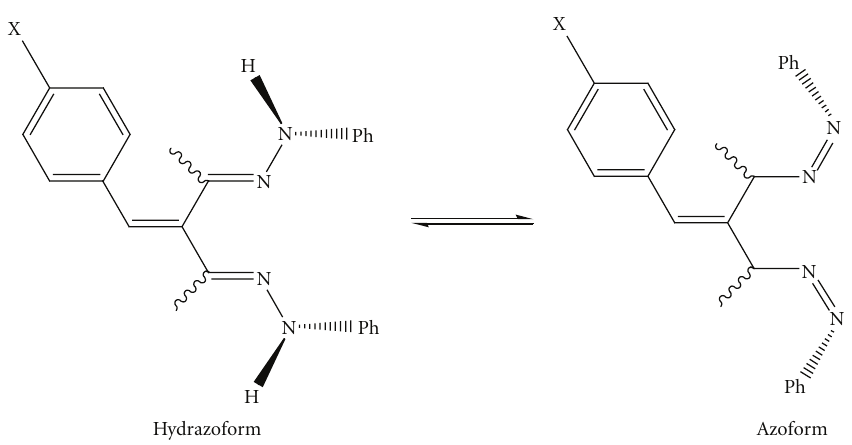
Figure 1: Tautomerization of the